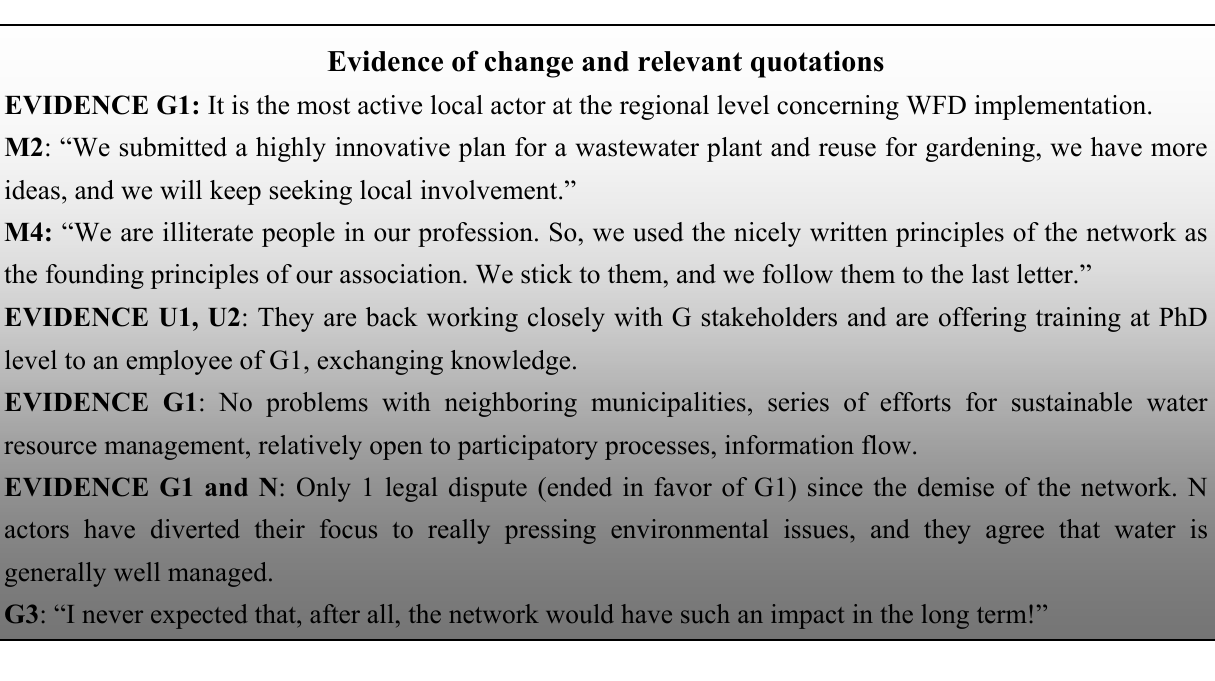
Figure 4. Summary of post-evaluation findings (in